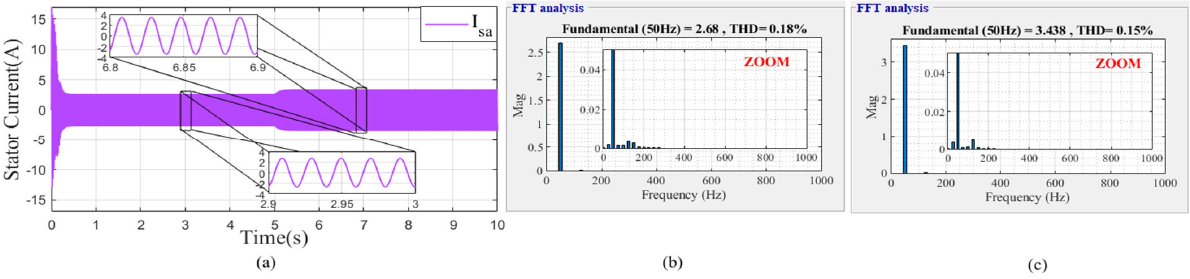
Figure 21. Performance with OR bearing defect of IM without control: ( a ) Stator current and ( b ) THD at no ‐ load and ( c ) THD with load (5 Nm).